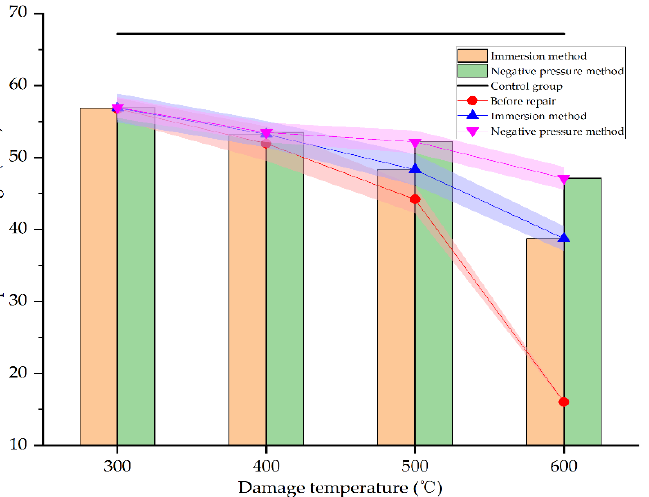
Figure 17. Compressive strength before and after repair by different methods and at different damage temperatures.